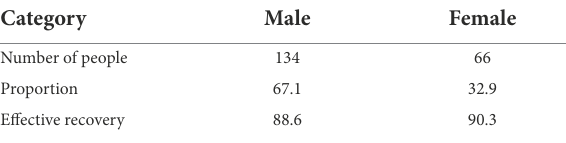
TABLE 1 Basic introduction of the